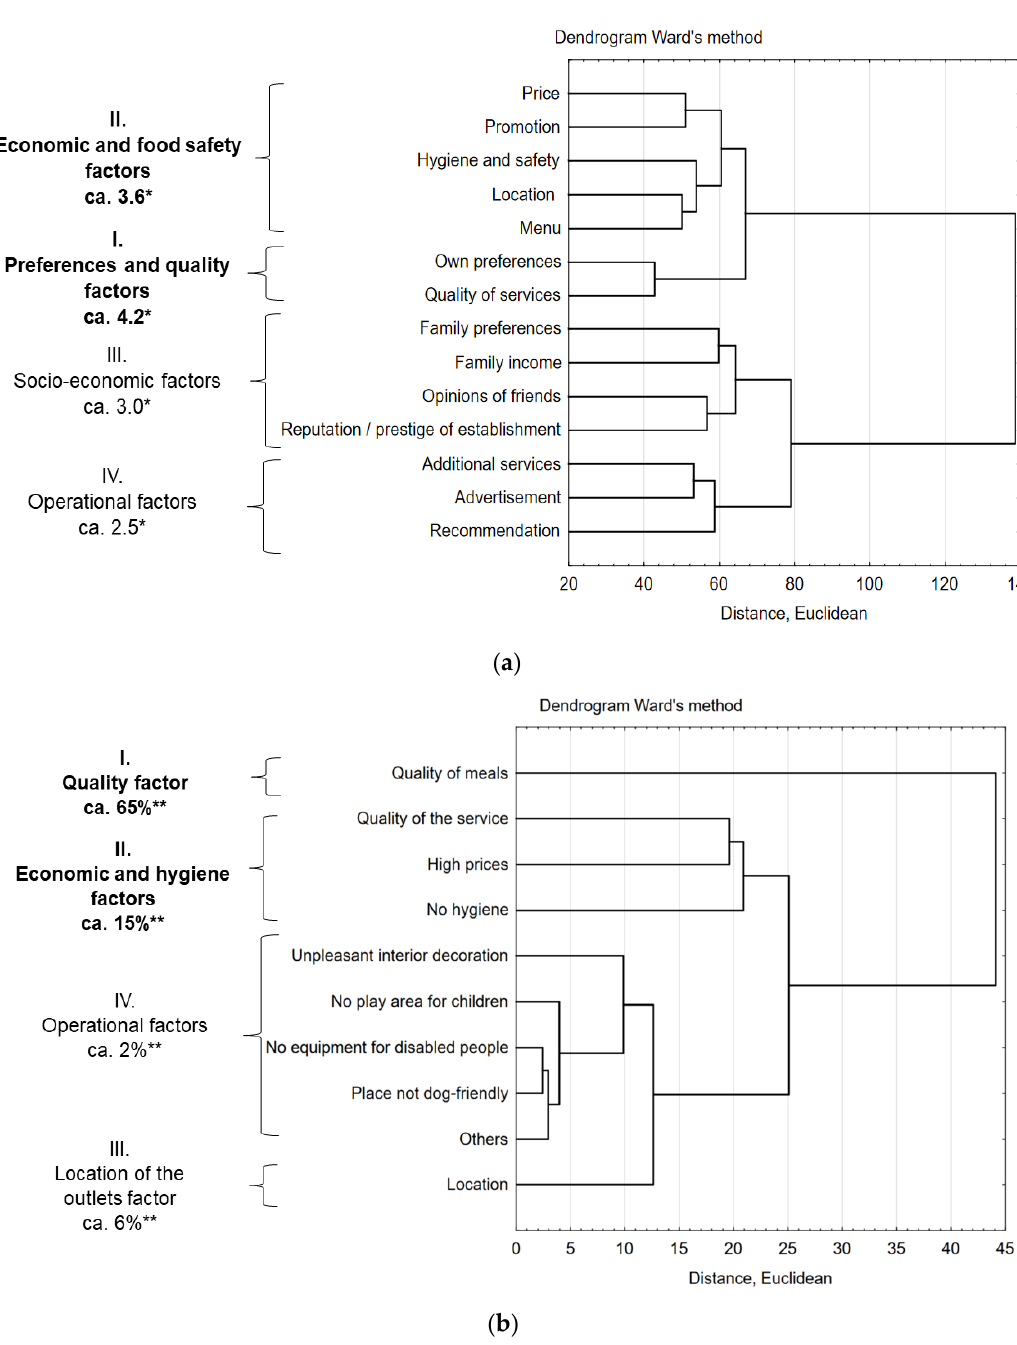
Figure 2. Factors determining ( a ) and discouraging ( b ) the selection of street food outlets (* factor importance on a 5-point scale, ** consumer % answer on the factor importance).